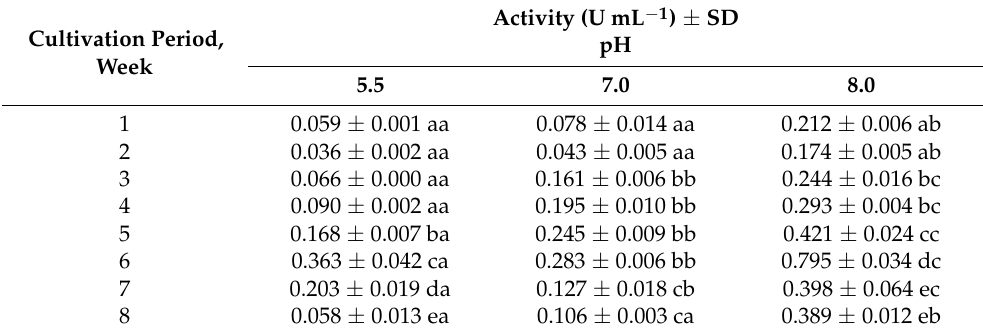
Table 5. β -glucosidase activity of P. melonis 502 under different pH values. Cultivation